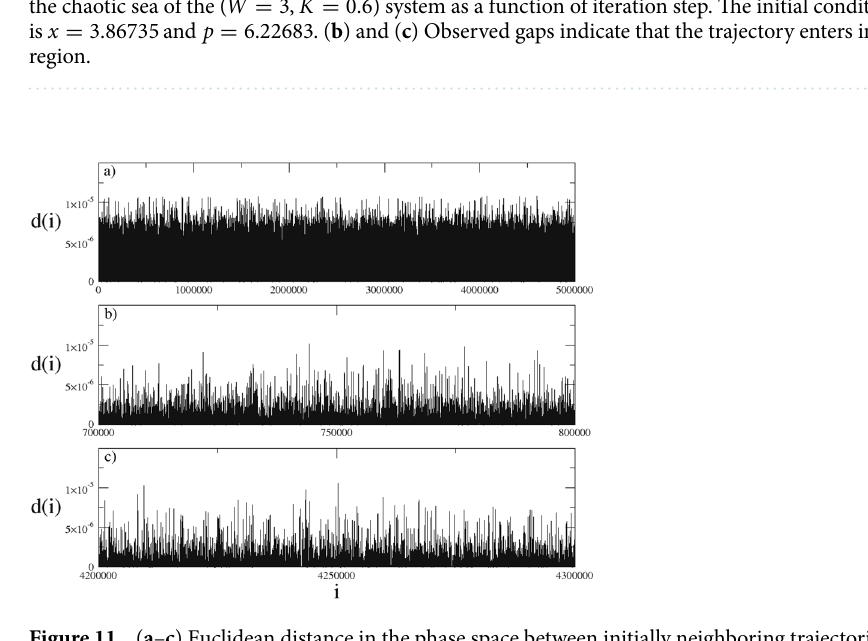
Figure 11. ( a – c ) Euclidean distance in the phase space between initially neighboring trajectories selected from the chaotic sea of the ( W = 3 , K = 0.6 ) system as a function of iteration step. The initial condition used here is x = 3 and p = 3